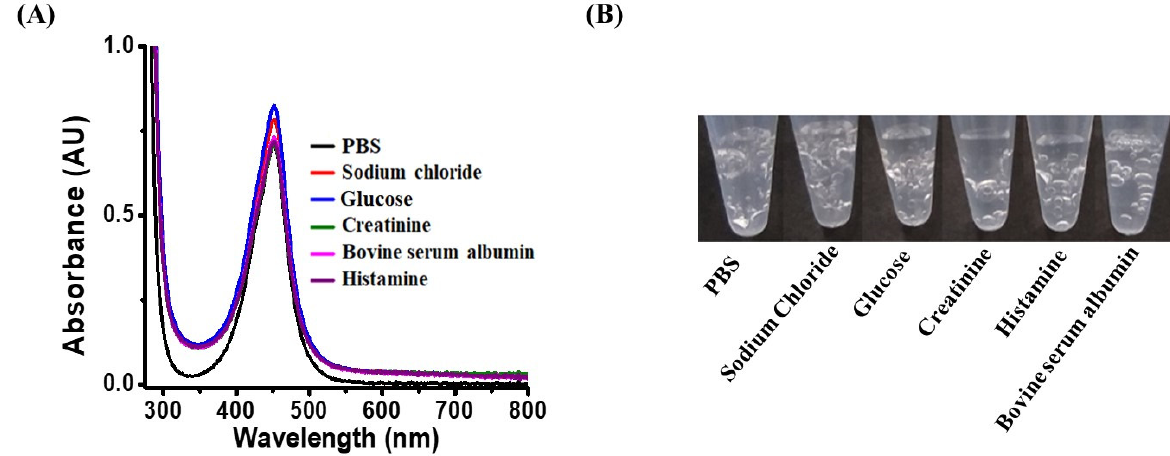
Figure 5. Examination of interference species effects. ( A ) UV–Vis absorption spectra of the samples (0.2 mL) containing E. coli O157:H7 (OD 600 = ~1) with the inferences species including sodium chloride (1 mM), potassium chloride (1 mM), creatinine (1 mM), bovine serum albumin (1 mM), and histamine (1 mM) obtained after reaction with H 2 O 2 (11.2 mM) and TMB (1.25 mM) for 25 min followed by the addition of sulfuric acid (2 M, 2 µL) to stop the reaction. All the samples were prepared in the phosphate buffer at pH 3. ( B ) Photograph of the samples (0.2 mL) containing S. aureus (OD 600 = 1) with interferences including sodium chloride (1 mM), potassium chloride (1 mM), creatinine (1 mM), bovine serum albumin (1 mM), and histidine (1 mM), obtained after the reaction with H 2 O 2 (180 mM) for 5 min.